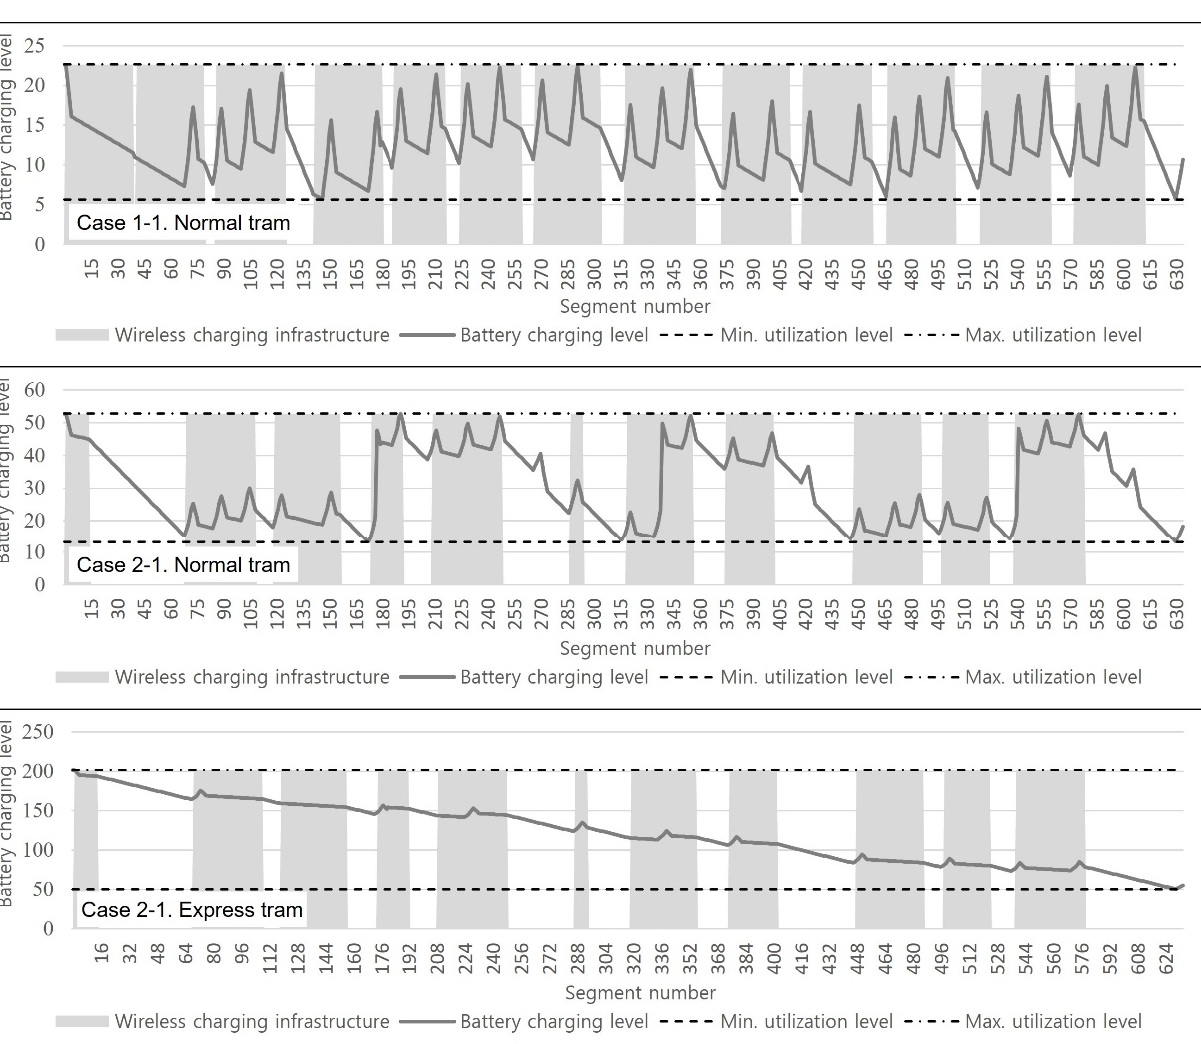
Figure 4. Variations of the battery charging level in Case 1-1 and Case 2-1.